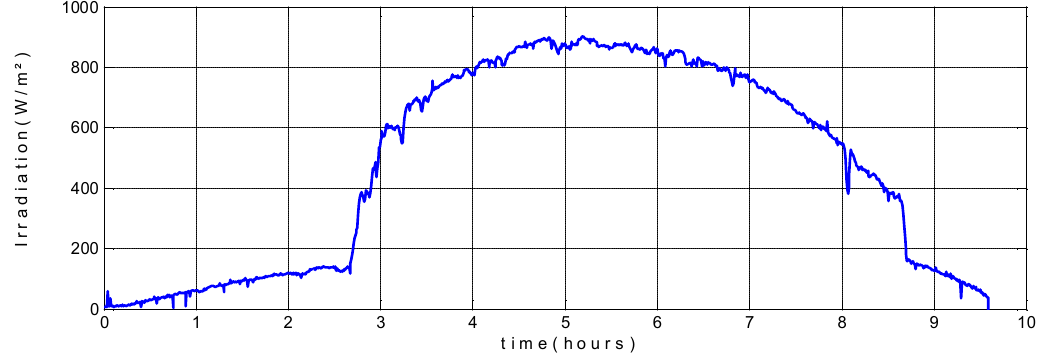
Figure 5. Variation of the illumination during a day in Tunis (Tunisia) on 5 April 2012.